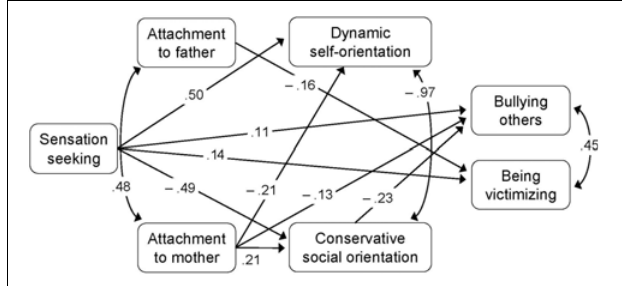
FIGURE 2 | Path analysis.